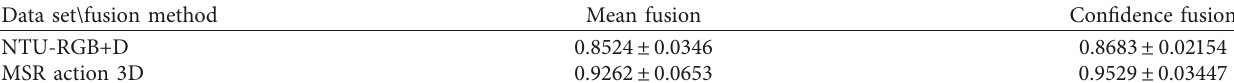
Table 2: Accuracy of action recognition with different fusion methods.